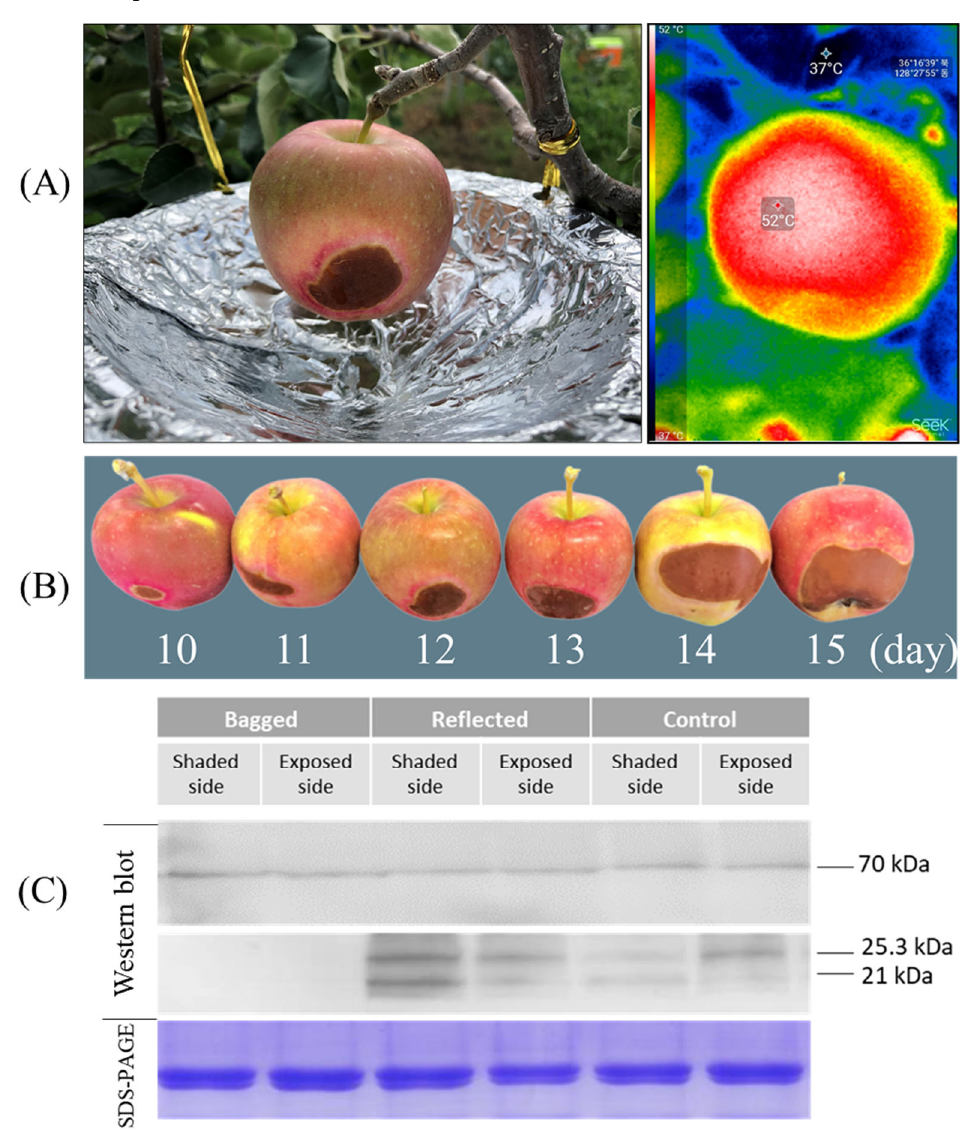
Figure 9. Symptoms of sunburn were observed on the shaded side in the fruit of ‘reflected sunlight’ where the fruit surface temperatures reached up to 52 °C in the hottest area, detected by thermal imaging ( A ). The sunburn damage was observed after ten days of sunlight treatment, and the damage level increased with increasing time of exposure ( B ). Immunoblotting assays (western blot) were carried out on the apple ‘Arisoo’ to evaluate the accumulation of smHSP in response to thermal stress with Coomassie Brilliant Blue ‐ stained (SDS ‐ PAGE) protein serving as a loading control ( C ).